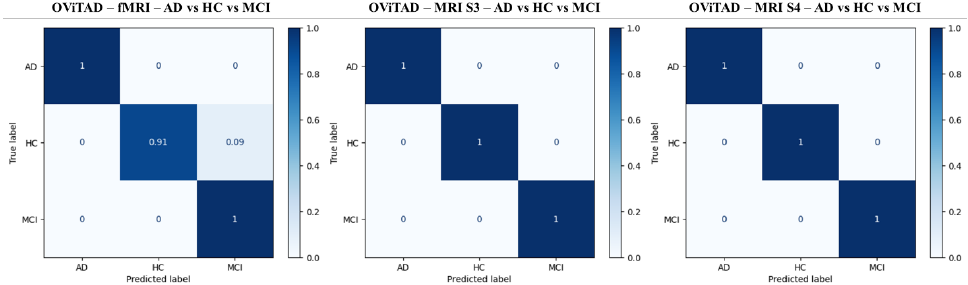
Figure 3. The normalized confusion matrices for the best-performing fMRI ( left ), MRI-S3 ( middle ), and MRI-S4 ( right ) OViTAD models to classify AD vs. HC vs. MCI at